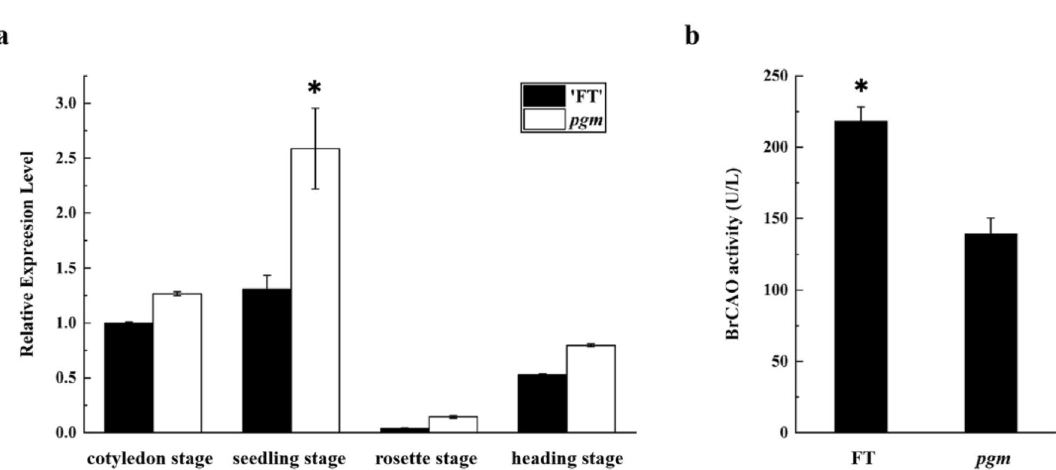
Figure 5. Expression analysis of BrCAO and enzyme assay of BrCAO. ( a ) The expression pattern of BrCAO in leaves of four stages (cotyledon, seedling, rosette, and heading stage) in pale green mutant ( pgm ) and wild-type (FT). ( b ) The CAO activity in pgm and FT. U/L = activity unit. The ‘*’ represents significant differences at 5%